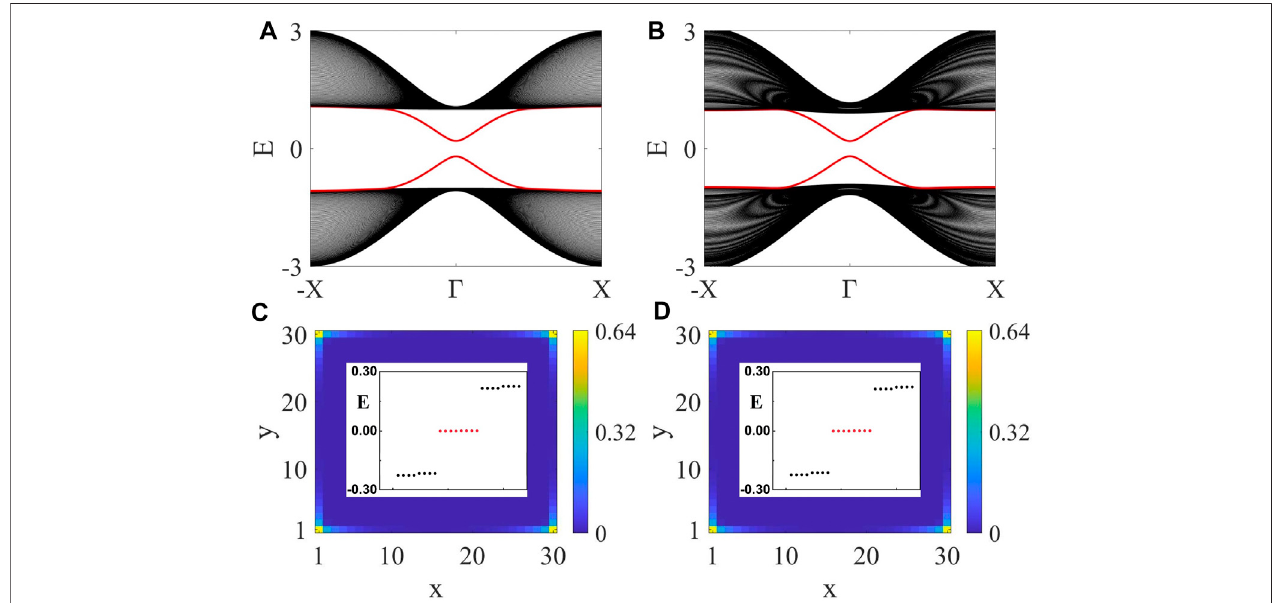
FIGURE 1 | (Color online) The response of edge states (red lines) and corner states (red dots) to an out-of-plane ferromagnetic-type Zeeman fi eld. Chosen parameters are: t = 1, m = 1, λ = 1, η = 0.2. In (A) and (C) , B z = 0. In (B) and (D) , B z = 0.1. In (A) and (B) , periodic and open boundary conditions are considered in the x and y directions,respectively.Thesystemsizeinthe y directionis N y =100.In (A) and (B) , Γ and X denote k x =0and π ,respectively.In (C) and (D) ,both x and y directions take open boundary conditions, and the probability density fi les of the zero-energy eigenstates (red dots in the inset) show that they are strongly localized at the lattice corners. A comparison of (A) and (C) with (B) and (D) reveals that the out-of-plane Zeeman fi eld has negligible effects on the edge states and corner states in the weak- fi eld